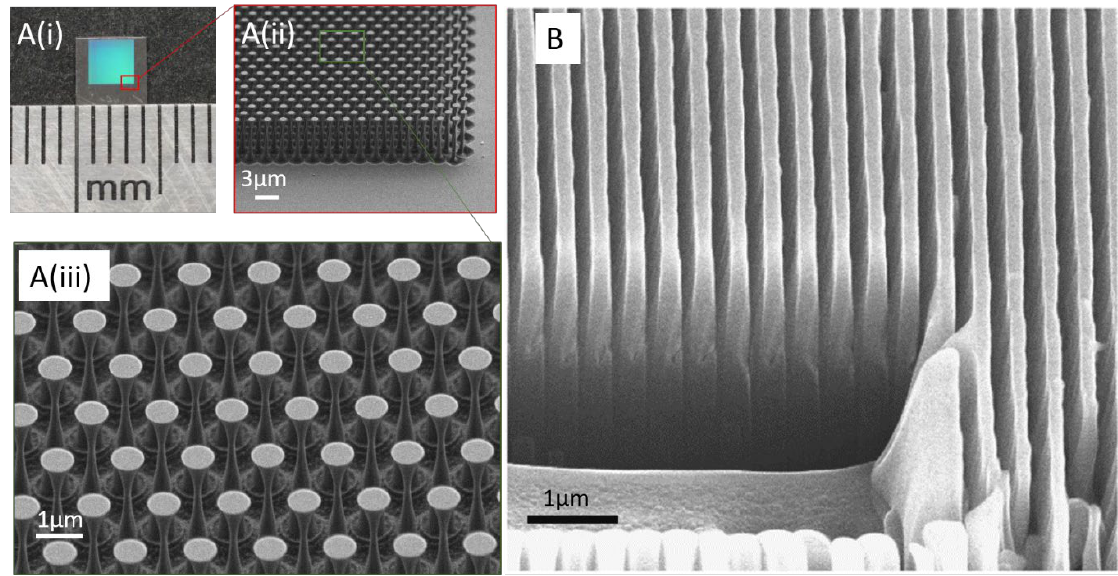
Figure 6. ( A ) (i) Optical microscope image of diamond mirrors (on 4.2 mm × 4.2 mm diamond chip) fabricated via reactive ion beam angled etching. Each division on the ruler measures 1 mm. A (ii) SEM image of the diamond mirror taken at 60° angle with zoomed in view A (iii) showing golf tee features of the mirror taken at 40° angle. Reprinted with permission from the author from Ref. [46]. ( B ) SEM image of 400 nm pitch diamond nanogratings fabricated via a combination of interferometric lithography and dry etching. Figure reprinted from Ref. [81] under creative commons CC BY 4.0 license.